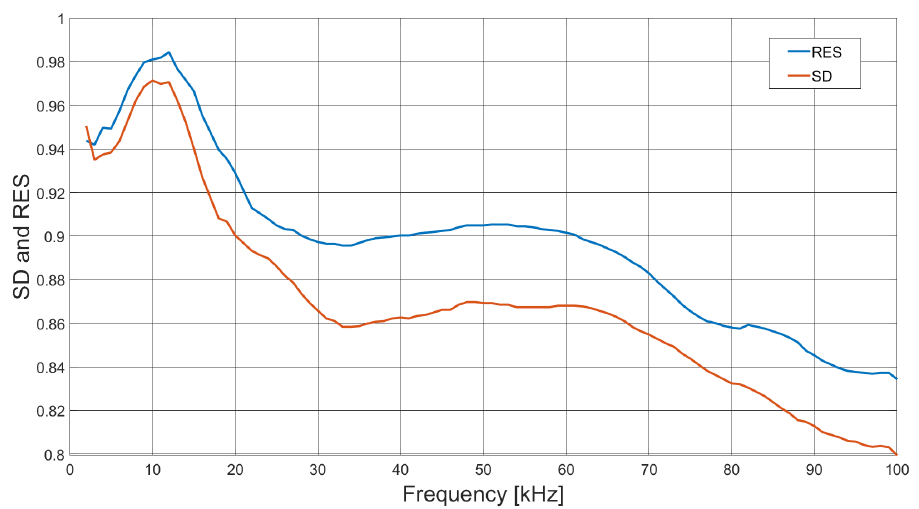
Figure 9. Reconstructed image resolution (RES) and shape deformation (SD) of dual aluminium external object inclusion data, applying a threshold value of k th = 0.3 in Equations (13)–(15), as a function of excitation field frequency 2 to 100 kHz.